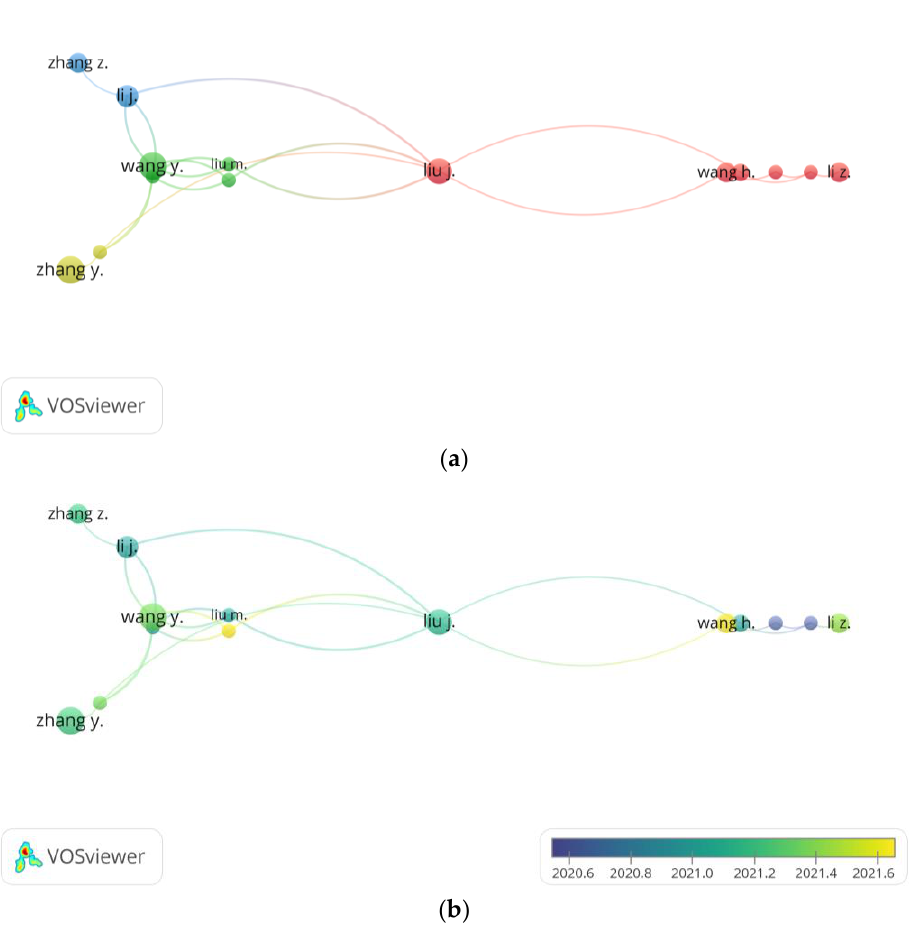
Figure 5. ( a ) Network visualization of authors citation (weights: citations). ( b ) Overlay visualization of author citations in 2020 – 2021 (weights: citations; score: average publications per year).